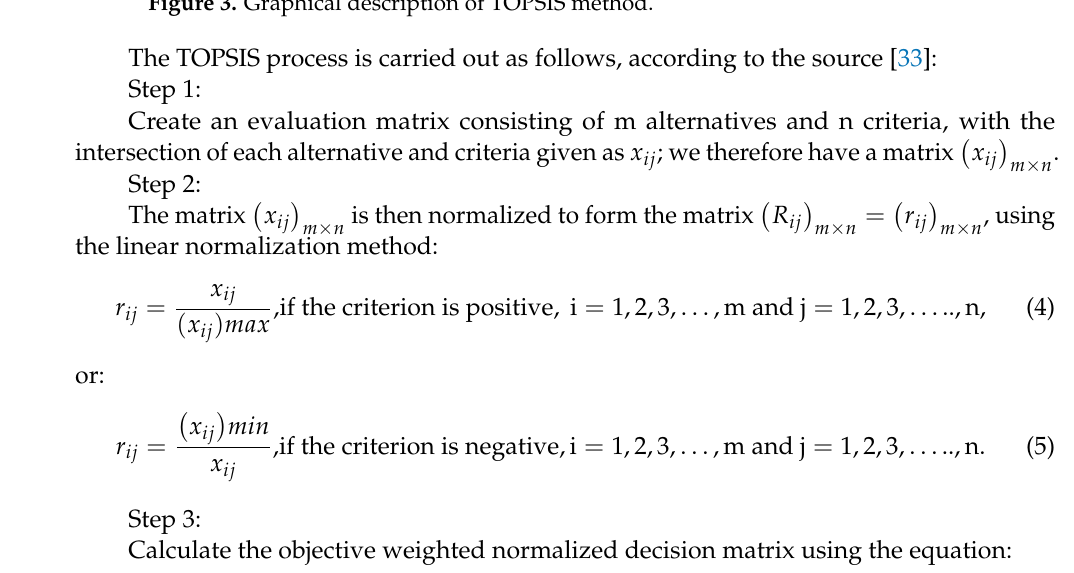
Figure 3. Graphical description of TOPSIS